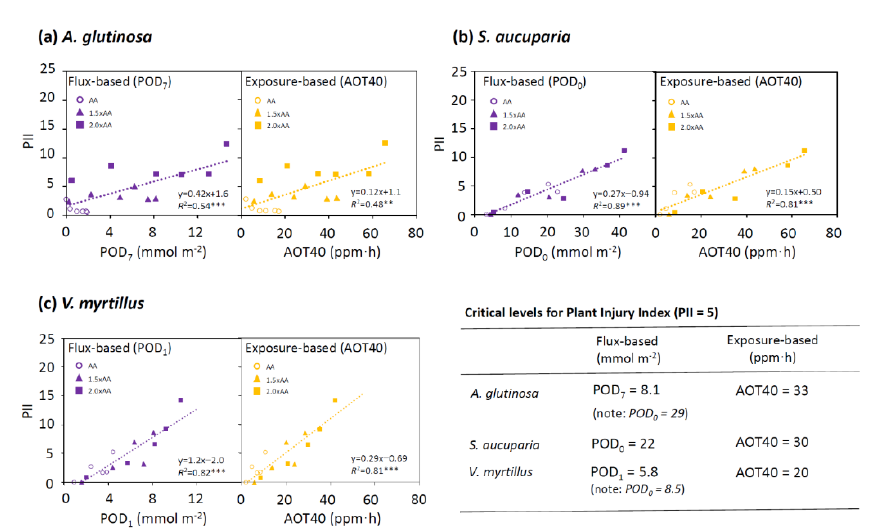
7 of 12 Figure 5. Parameterization of f light , f temp , f VPD , and f phen in stomatal conductance model for Alnus glutinosa , Sorbus aucuparia, and Vaccinium myrtillus exposed to three levels of O 3 concentration (AA, ambient O 3 concentration 1.5 × AA, and 2.0 × AA). Red lines show model functions and black points show measured stomatal conductance. 3.4. Dose-Response Relationship for Plant Injury Index